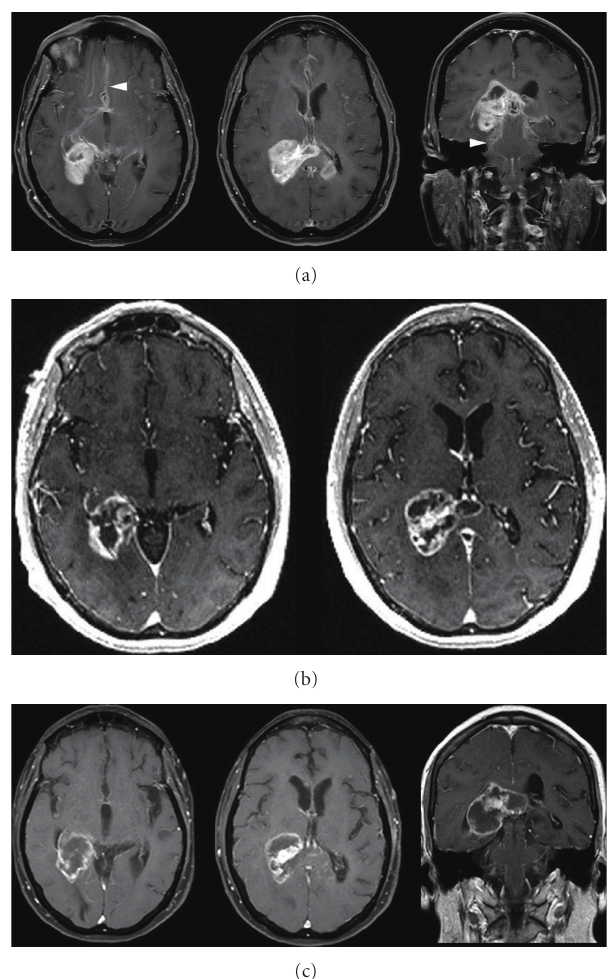
Figure 1: (a) Initial contrast-enhanced axial and coronal T1- weighted fast spin echo (FSE) sequence demonstrating an avidly enhancing temporoparietal mass in a 57-year-old female patient who presented with short-term memory loss, headaches, subtle left- sided weakness, and unsteady gait. There is enlargement of the splenium with nodular enhancement within the contralateral cor- pus callosum. Extensive areas of subependymal and leptomeningeal enhancement (arrowheads) are present. (b) Contrast-enhanced axial spoiled gradient recalled (SPGR) sequence demonstrating overall decreased enhancement with formation of centrally necrotic areas after 5 days of corticosteroid therapy. The patient’s improved functional status and the radiographic regression of the mass suggested a diagnosis of lymphoma. (c) Axial and coronal T1- weighted, contrast-enhanced FSE image obtained two weeks later showing increased nodular enhancement along the inferior and medial margins of the dominant mass and evolution of the necrotic areas. These changes suggested a diagnosis of